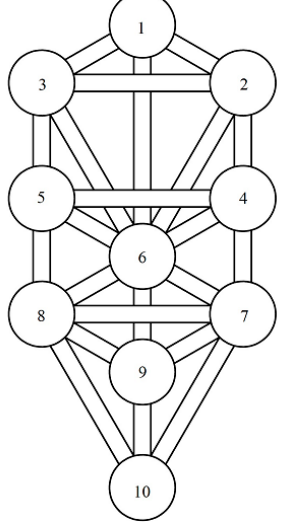
Figure 1. A Schematic of the Tree of Life as Taught in the Golden Dawn.